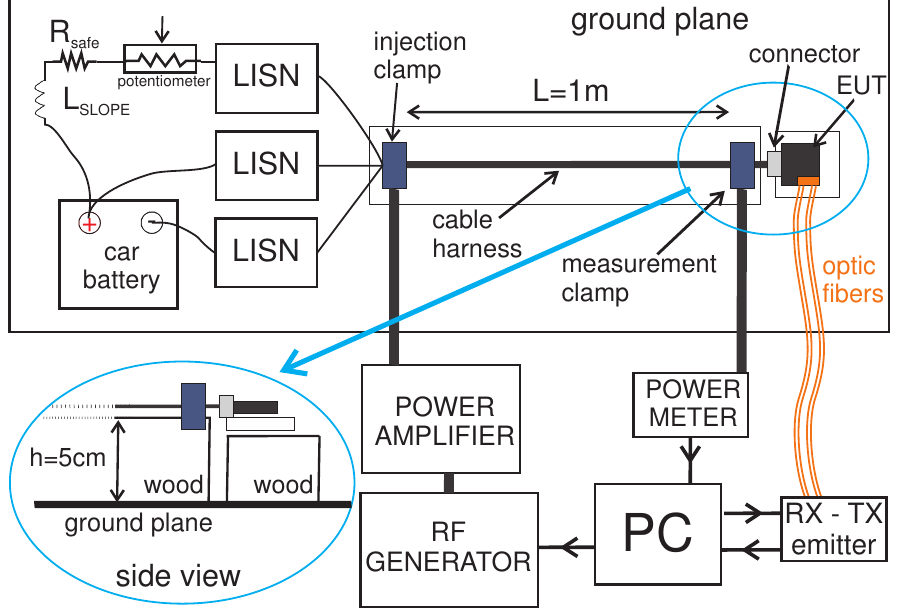
Figure 6. Pictorial representation of BCI test setup